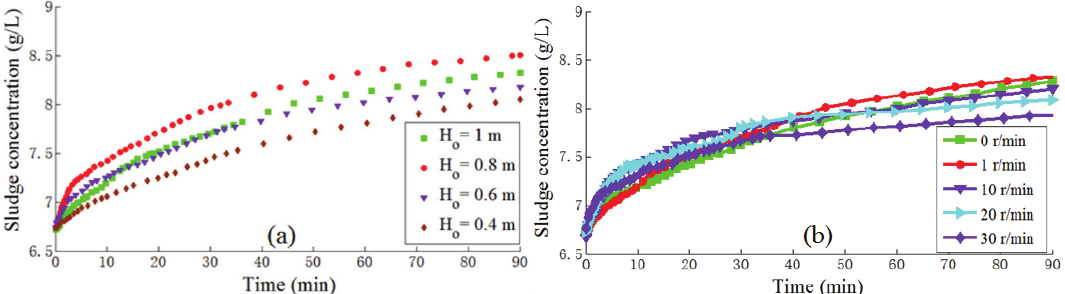
Figure 5. Sludge concentration at the bottom of secondary settlers under ( a ) different initial sludge heights and ( b ) different stirrer